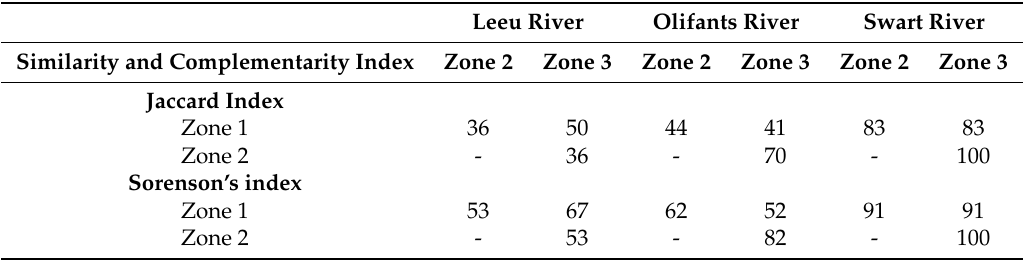
Table 3. The Jaccard’s and Sorenson’s coe ffi cients of similarity between the three zones sampled along the Leeu, Olifants, and Swart rivers, expressed as